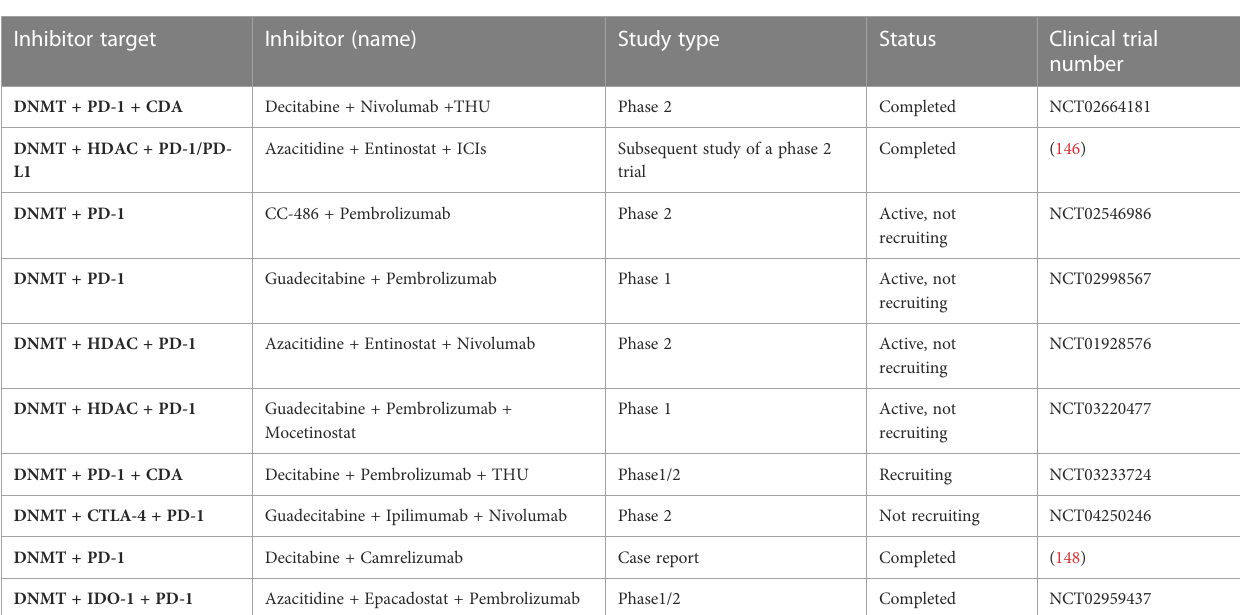
TABLE 4 Clinical trials of DNMTis combined with immunotherapy in